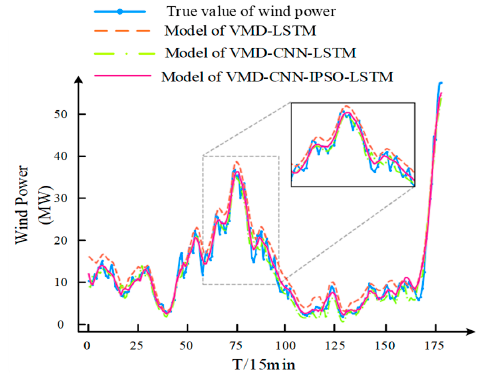
Figure 8. Wind power predicted value and real value of each model.